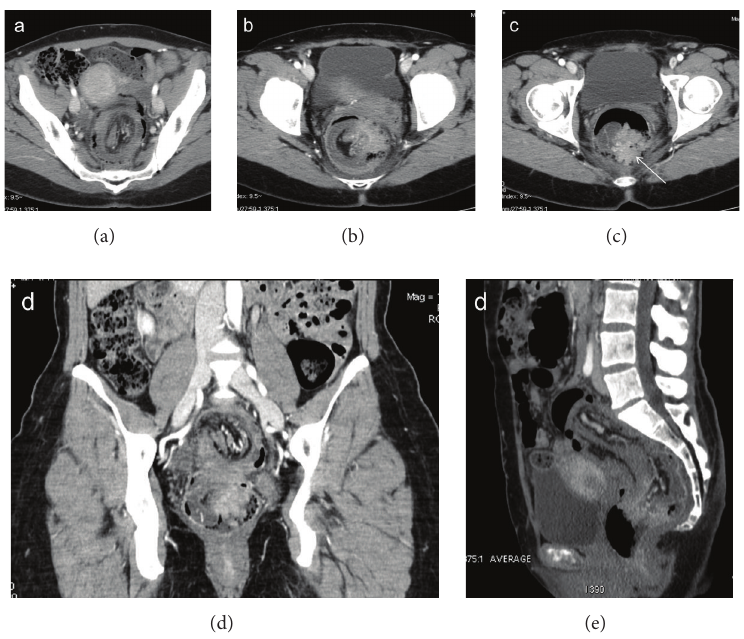
Figure 12: Colocolonic (sigmoid-rectal) intussusception (a) caused by sigmoid adenocarcinoma. The enhanced neoplastic mass, which acts as the lead point, is located in the rectum (arrow), at the tip of intussusceptum (b, c, d, and